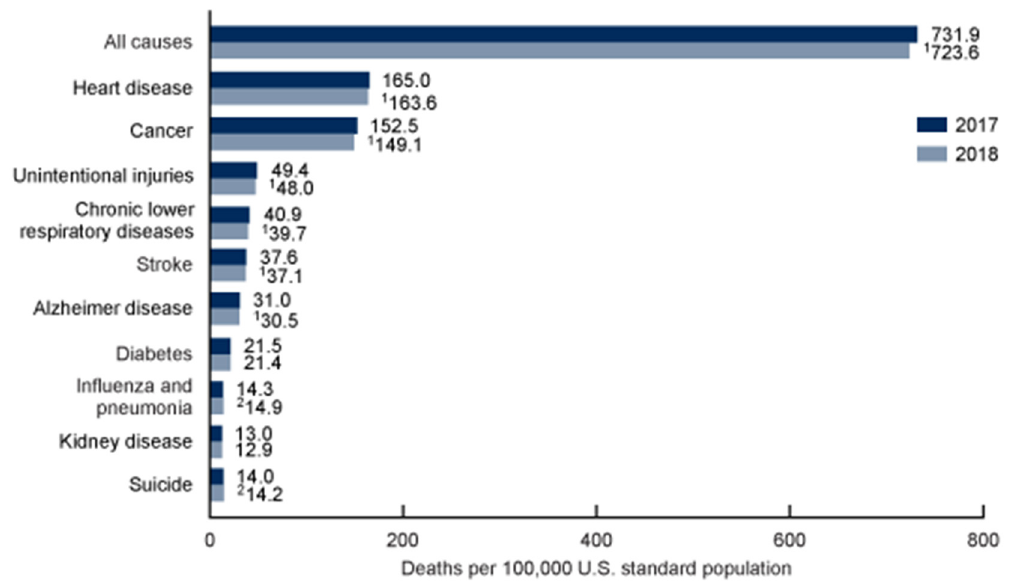
Figure 1. The 2018 Center for Disease Control and Prevention report on the leading causes of death from 2017 to 2018. 1 Statistically significant decrease in age-adjusted death rate from 2017 to 2018 ( p < 0.05). 2 Statistically significant increase in age-adjusted death rate from 2017 to 2018 ( p < 0.05).NOTES: A total of 2,839,205 resident deaths were registered in the United States in 2018. The 10 leading causes of death accounted for 73.8% of all deaths in the United States in 2018. Causes of death are ranked according to number of deaths. Rankings for 2018 were the same as in 2017. Data table for Figure 2 includes the number of deaths for leading